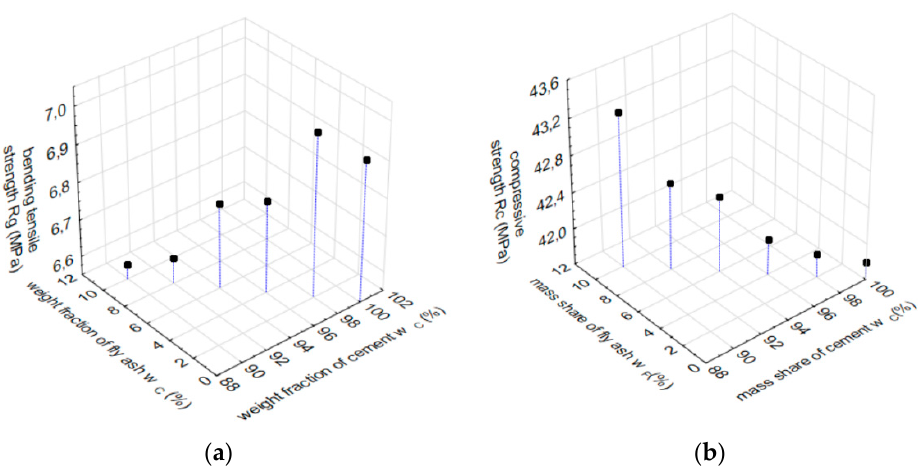
Figure 3. ( a ) Dependence of average flexural tensile strength Rg, and ( b ) compressive strength Rc on the simultaneous change of cement and fly ash.